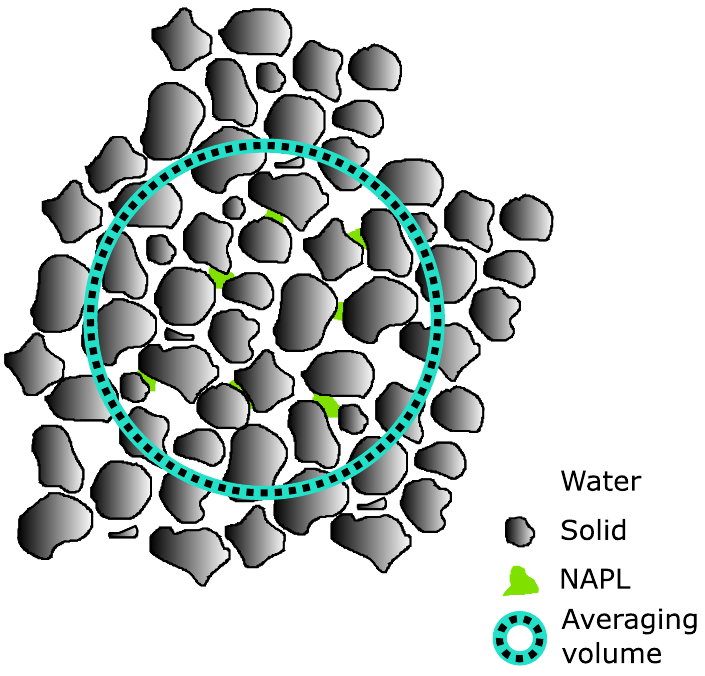
Figure 1. Schematic diagram of blobs of residual NAPL in pores defined by solid media otherwise saturated with water, with averaging volume